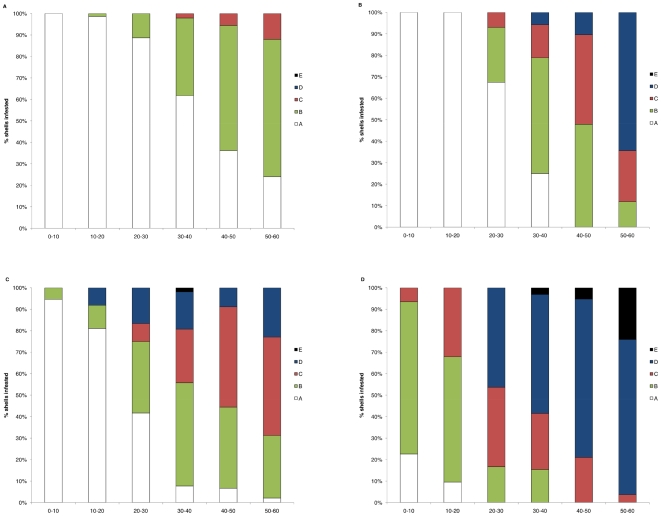
Degrees of infestation of different size classes: micro-scale comparison between shaded and non-shaded sites.Proportions of shells exhibiting different degrees of infestation severity (Groups A–E, see Fig. 1) and grouped into 10 mm size classes. Infestation severity was determined in the mid-mussel zone at (a) shaded and (b) non-shaded sites for P. Perna and at (c) shaded and (d) non-shaded sites for M. galloprovincialis.